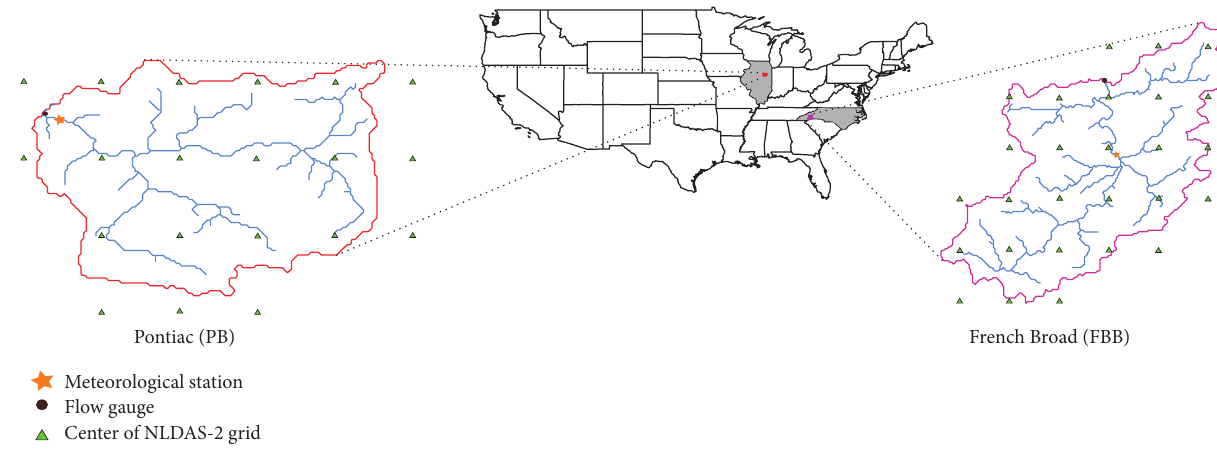
Figure 1: Locations of the Pontiac basin (PB; 1500 km 2 ) and the French Broad basin (FBB; 2448 km 2 ) with flow gauges and NLDAS-2 grids over river network